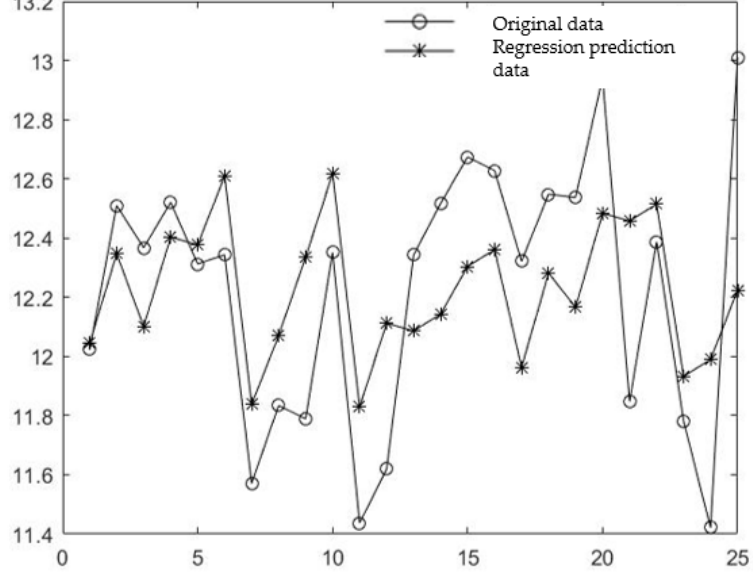
Figure 5. Comparison of experimental data and model prediction data.